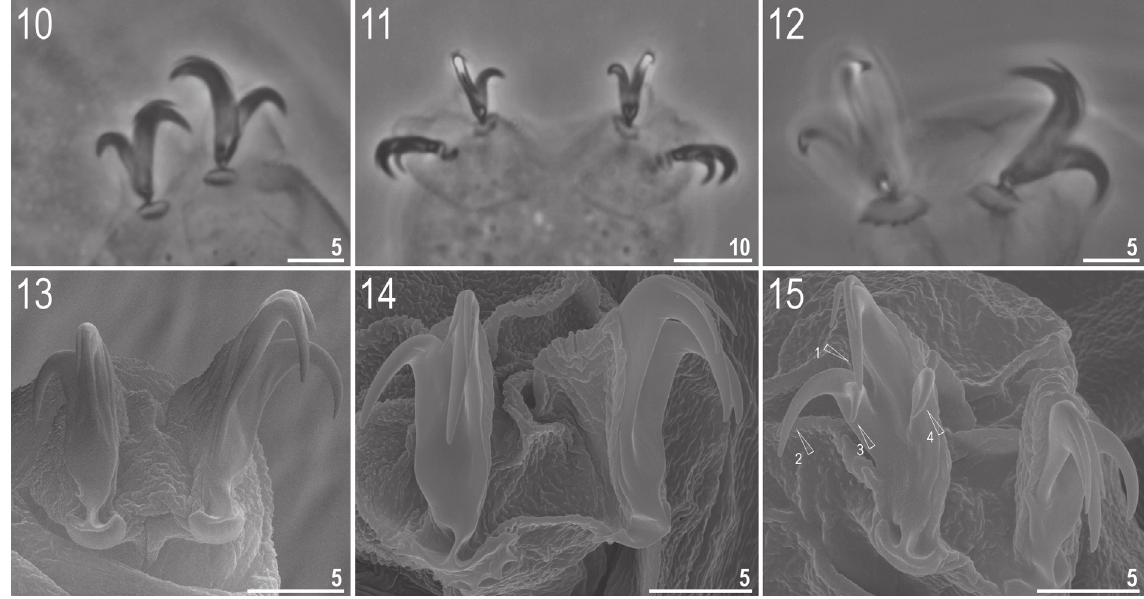
Figs 10–15. Claws. 10 . Claw II with smooth lunules (PCM, paratype). 11 . Claw IV (PCM, holotype). 12 . Indented lunules on claw IV (PCM, paratype). 13 . Claw I with smooth lunules (SEM, paratype). 14 . Claw IV with indented lunules (SEM, paratype). 15 . Aberrant claw IV (SEM, paratype). Numbers 1–2 indicate normally developed claw branches/spurs, whereas 3–4 indicate aberrant claw branches/ spurs. Scale bars in